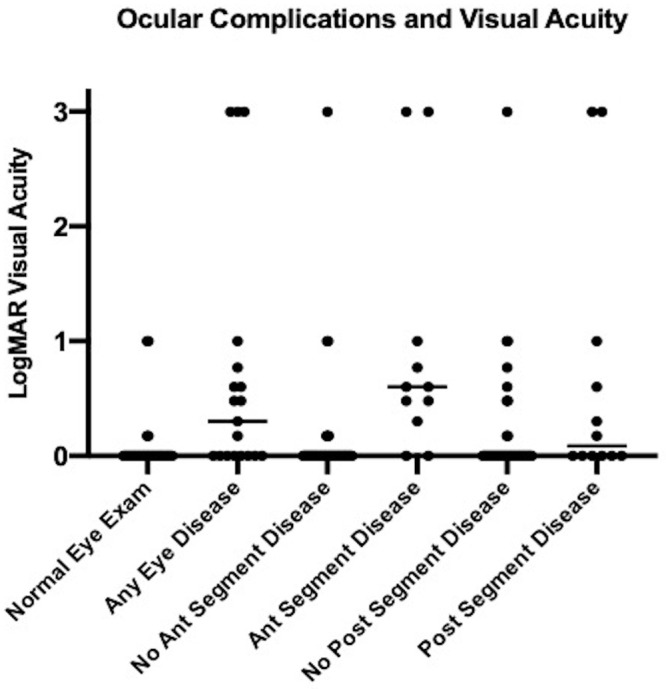
Scatter plot of logMAR visual acuity with medians represented by horizontal bars.Lassa fever survivors with any eye disease showed worse visual acuity than those patients with normal eye examination (p<0.0001). Eyes with anterior segment or posterior segment also showed worse visual acuity when compared to those without disease (p<0.0001 for anterior segment comparison and p<0.013 for posterior segment disease).